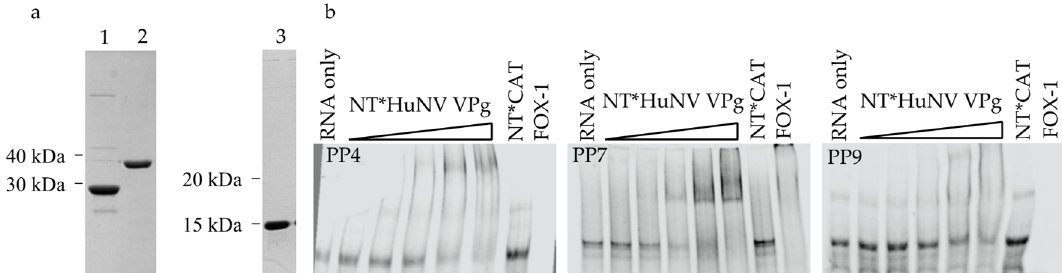
Figure 6. HuNV VPg binds RNA . ( a ) Coomassie blue stained SDS-PAGE gel of purified protein (3 μ g) used for RNA binding experiments. 1; NT*HuNV VPg, 2; NT*CAT, 3; FOX-1. ( b ) RNA EMSA of NT*HuNV VPg with pentaprobe RNA. Proteins were incubated with 100 nM UTP ATTO 680 labelled pentaprobe RNA for 30 min, separated on a 5% TBE gel, and directly imaged in the 700 nm channel. The concentration of NT*HuNV VPg was increased from 0.5 µ M to 8 µ M in 2-fold increments. NT*CAT (8 µ M) was included as a negative control and FOX- 1 (8 µ M) as a positive